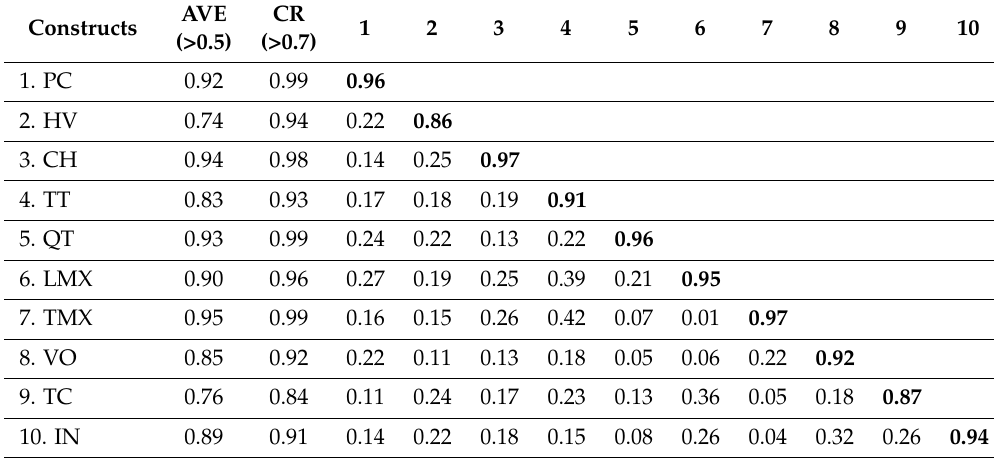
Table 2. Convergent and discriminant validity